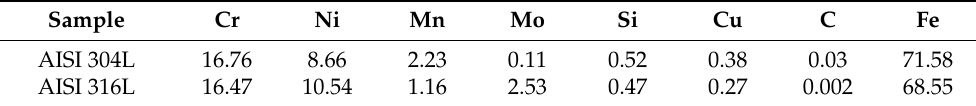
Table 1. Chemical composition of investigated stainless steels (in wt.%). Sample